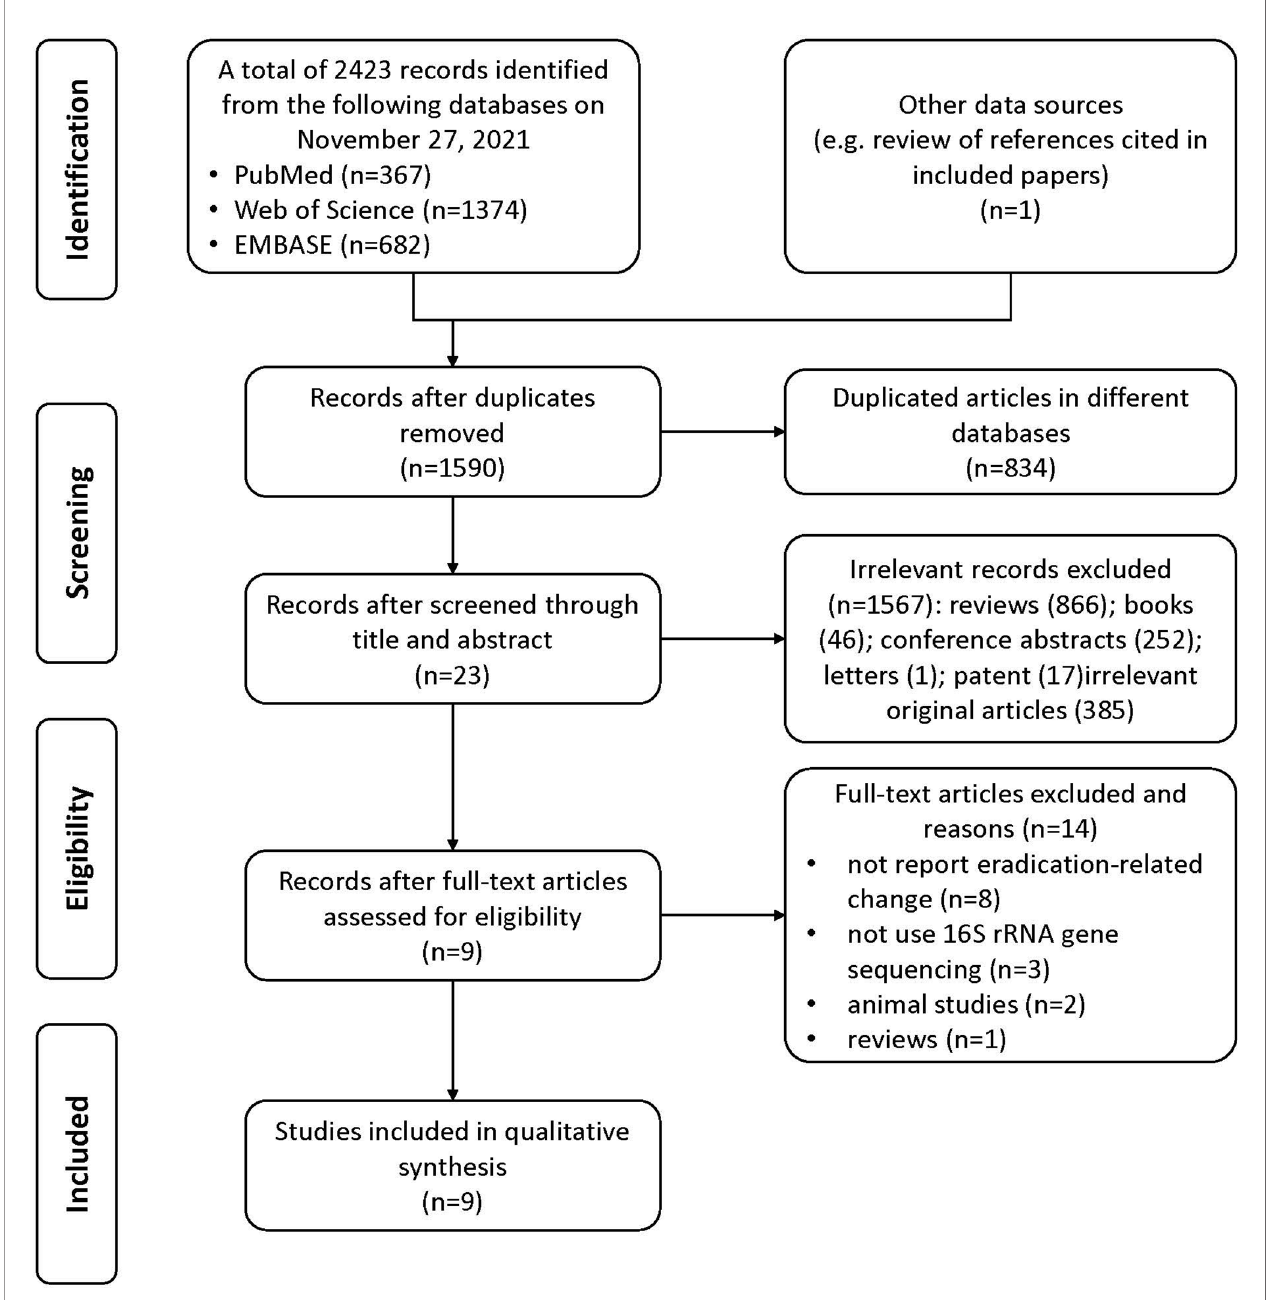
FIGURE 1 | Flow chart of literature identi fi cation and selection